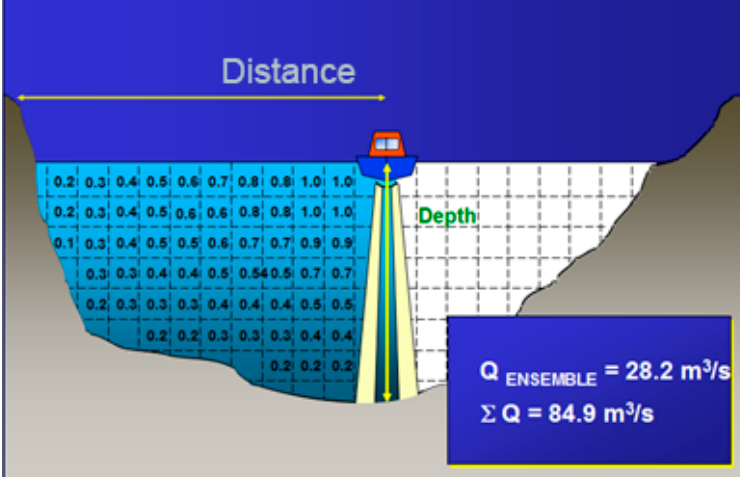
Figure 4. Schematic diagram of the principle of ADCP flying aerial flow measurement.